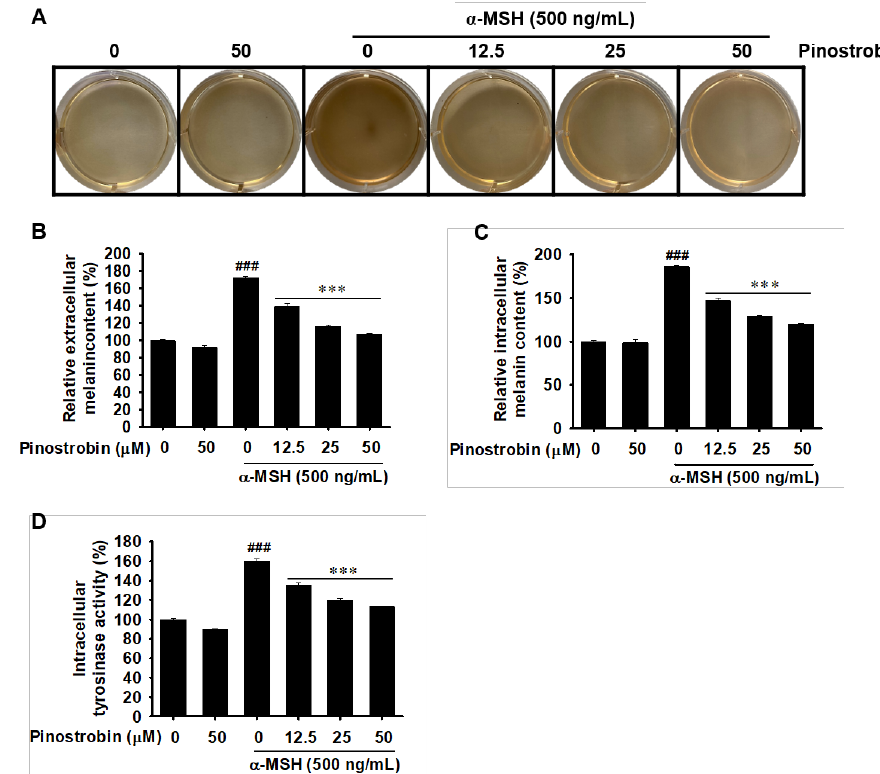
Figure 4. Pinostrobin decreases α -melanocyte-stimulating hormone ( α -MSH)-stimulated melanin production and intracellular tyrosinase activity. B16F10 melanoma cells were stimulated with 500 ng/mL α -MSH for 24 h followed by treatment with pinostrobin (0 – 50 µM) for 48 h. ( A ) The color change of each well. ( B ) Extracellular melanin content following stimulation with or without α -MSH and treatment with pinostrobin. ( C ) Intracellular melanin content following stimulation with or without α -MSH and treatment with pinostrobin. ( D ) Intracellular tyrosinase activity following treatment with B16F10 cells with pinostrobin and stimulation with or without α -MSH. The data are represented as mean ± SE. ### p < 0.001 vs. untreated cells; *** p < 0.001 vs. α -MSH-treated cells.